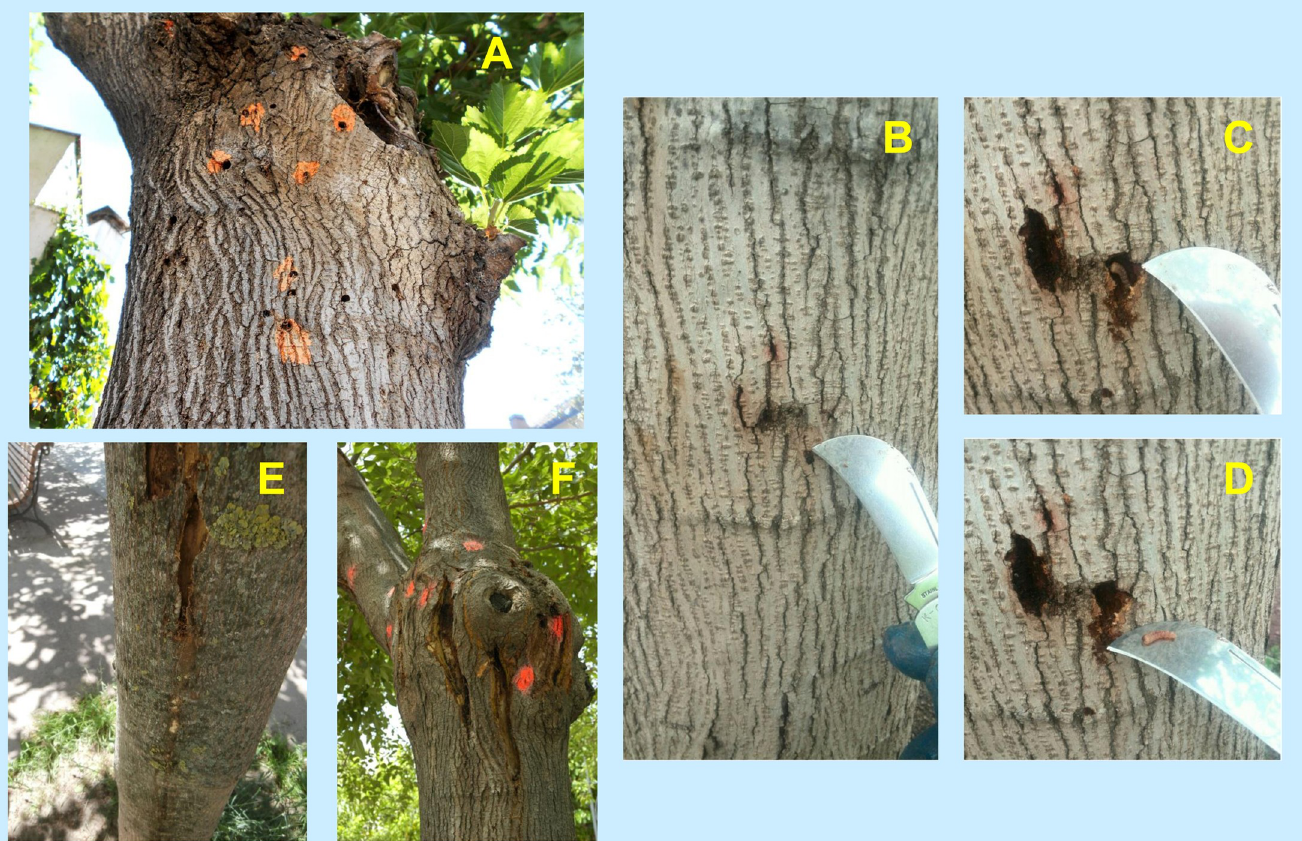
Fig 4. X . chinensis infestation indicators on mulberry trees. (A) Adult beetle emergence holes (most coloured orange) on the trunk of a tree. (Photo G. Torras). (B to D) Bark injury caused by beetle larvae: (B) as seen before removing the dead and dry periderm to discover the feeding gallery underneath, and one beetle larva (C) and (D). (Photos J. Serra). (E-F) Gallery slits caused by beetle larvae: (E) on the trunk, (F) on the crown base. Coloured spots signal emergence holes. (Photos G. Torras (E); V. Sarto i Monteys (F)).